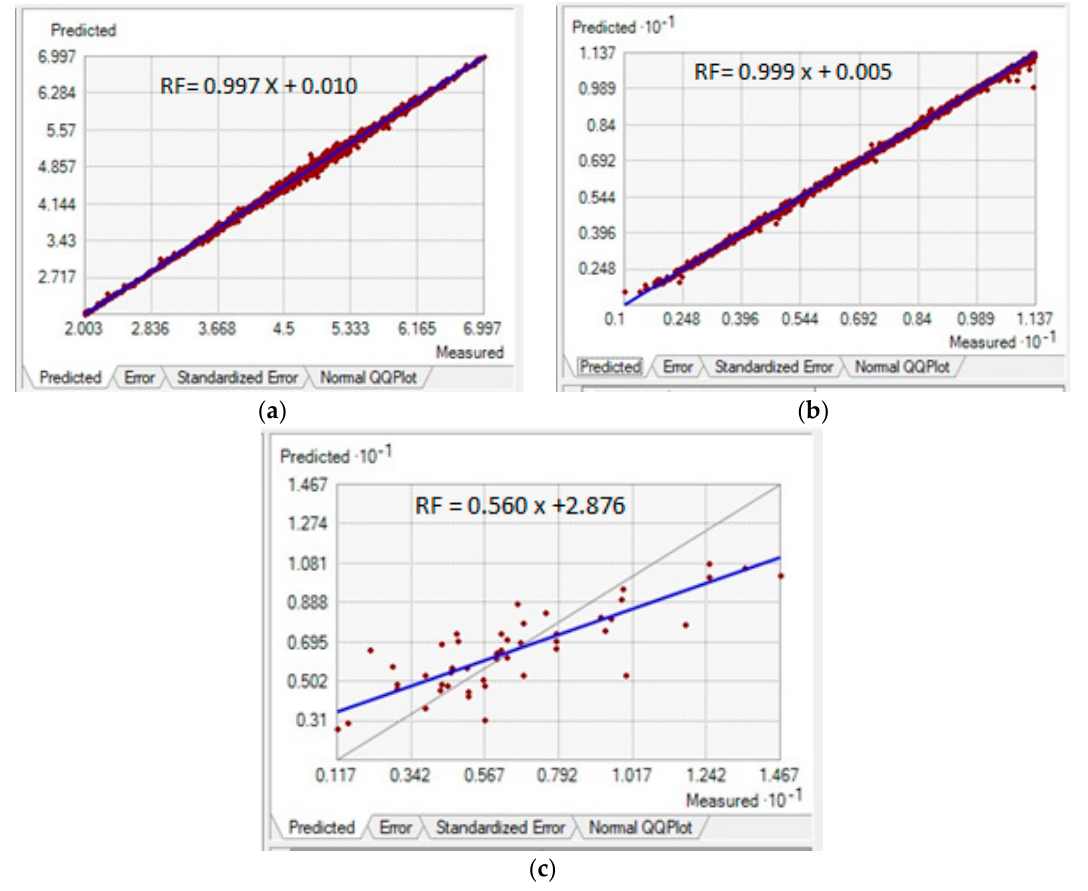
Figure 9. ( a ) Statistical Evaluation of AASHTO Map; ( b ) Statistical Evaluation of Allowable Bearing Capacity Map; ( c ) Statistical Evaluation of Engineering Soil Classification Map.